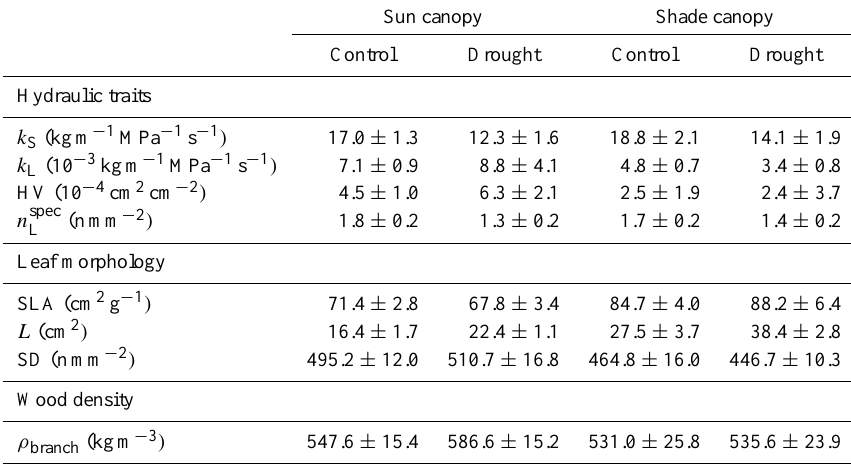
Table 3. Hydraulic properties of the branch xylem, leaf morphological traits and branch wood density in the sun and shade canopy of C. acuminatissima . Leaf-specific conductivity ( k L ) , sapwood-specific conductivity ( k S ) , Huber value (HV), specific leaf area (SLA), leaf size ( L) , stomatal density (SD), and branch wood density ( ρ branch ) . Given are means ± SE per treatment ( n = 7). For within-tree replicates see Material and Methods.